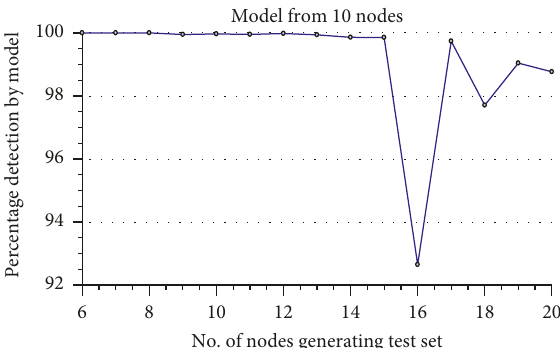
Figure 14: Simulation results for 10